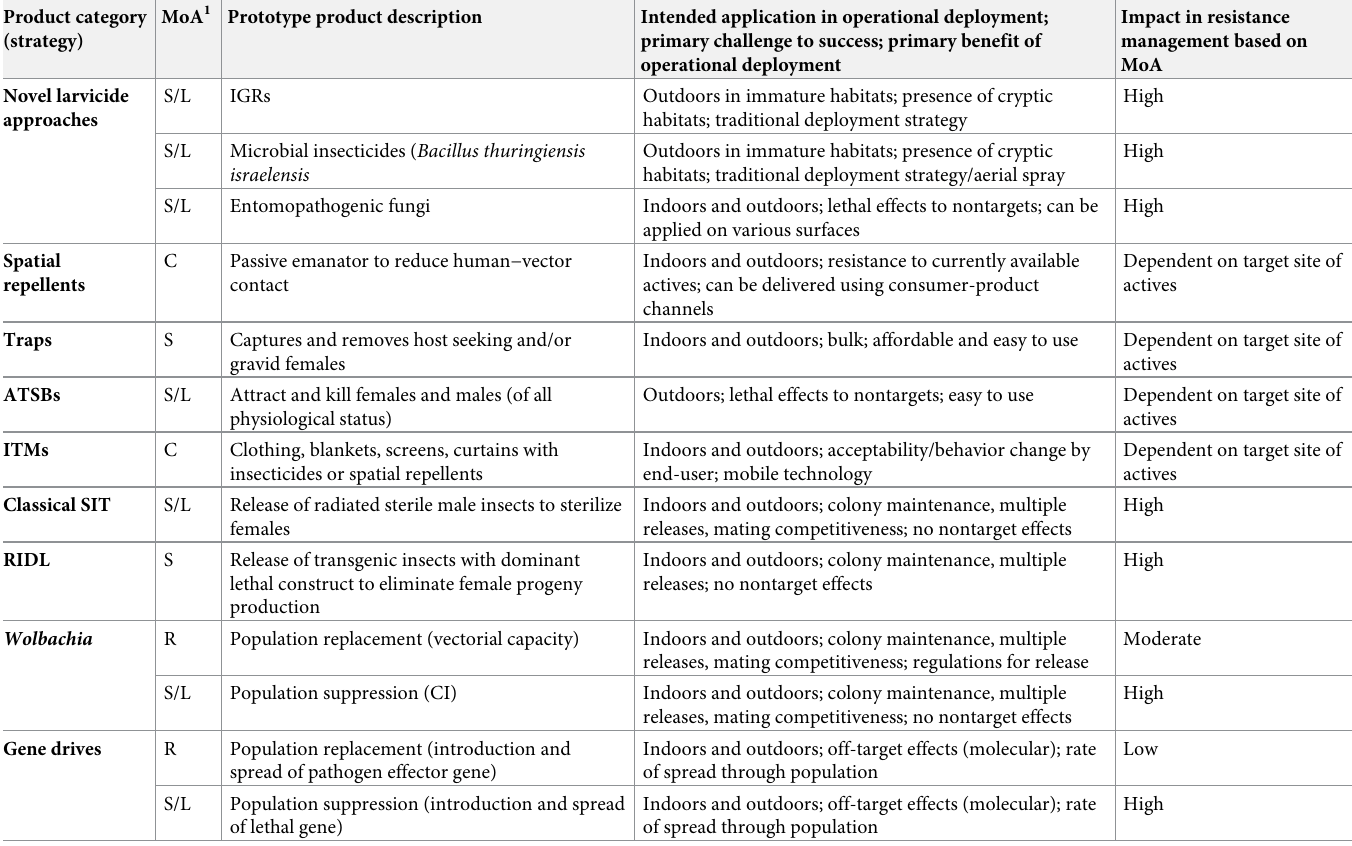
Table 2. Summary description of alternative vector-control tools, primary challenges, and benefits to include probability of mitigating evolutionary response/ impact in resistance management. Product category